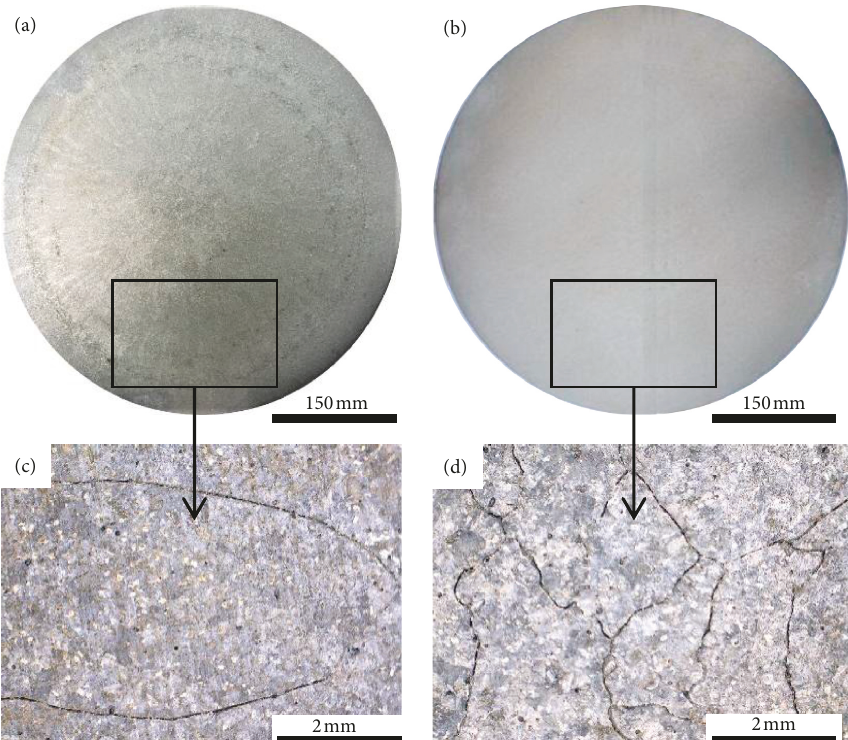
Figure 6: Macrostructures of ingots: (a) conventional ingot; (b) ultrasonic ingot; (c) edge morphology of the conventional ingot; (d) edge morphology of the ultrasonic